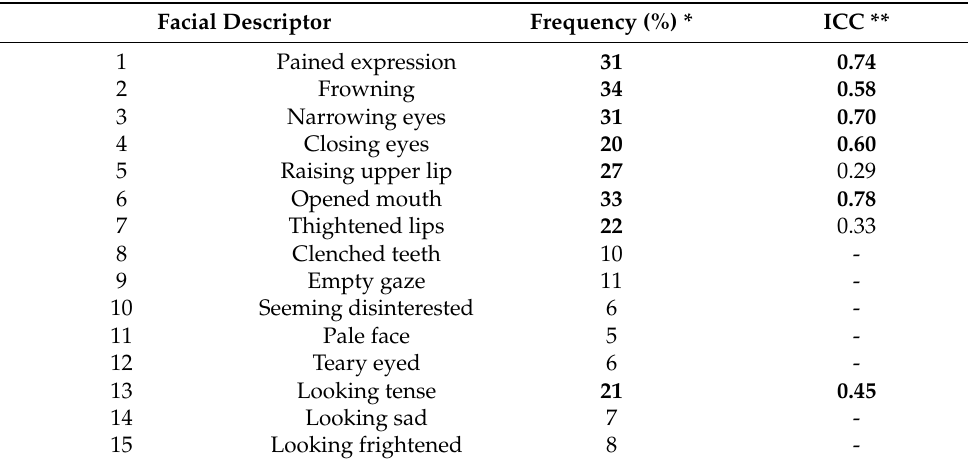
Table 2. Step 1 (item selection): Facial descriptor frequency and